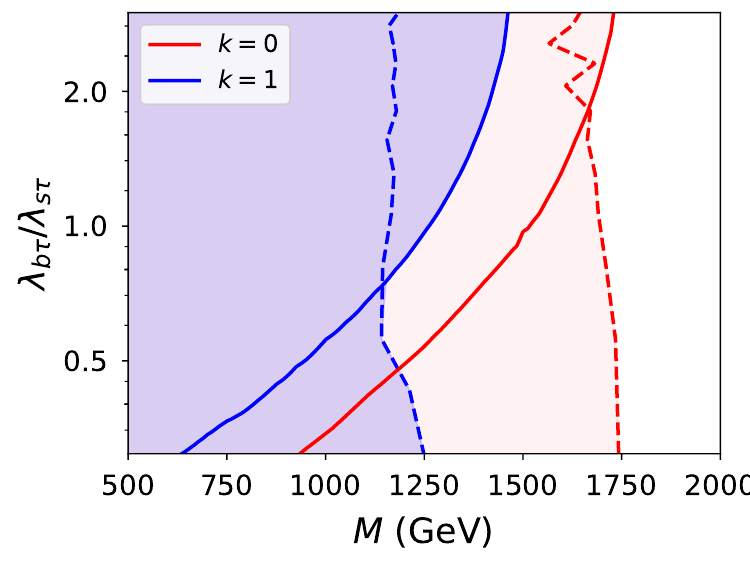
Figure 6 . Combined results from CheckMATE nj + /E lines correspond to the mixed channel while the dashed ones are the results from CheckMATE . Note that the y-axis has a base 2 logarithmic